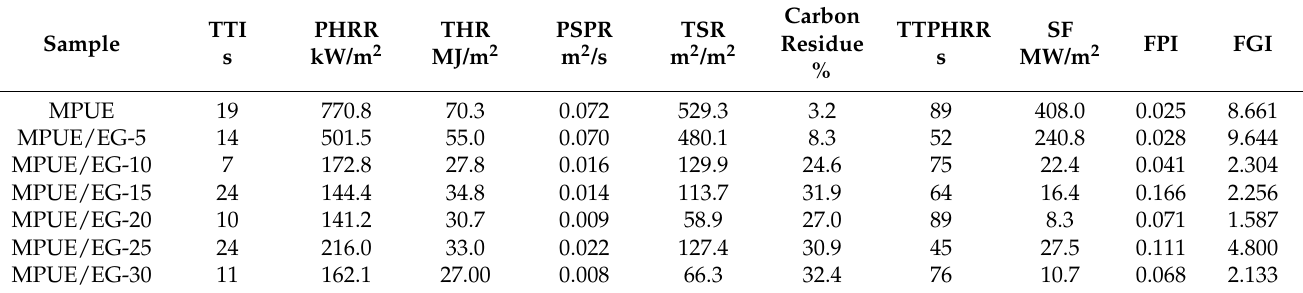
Table 8. Cone calorimeter analysis of